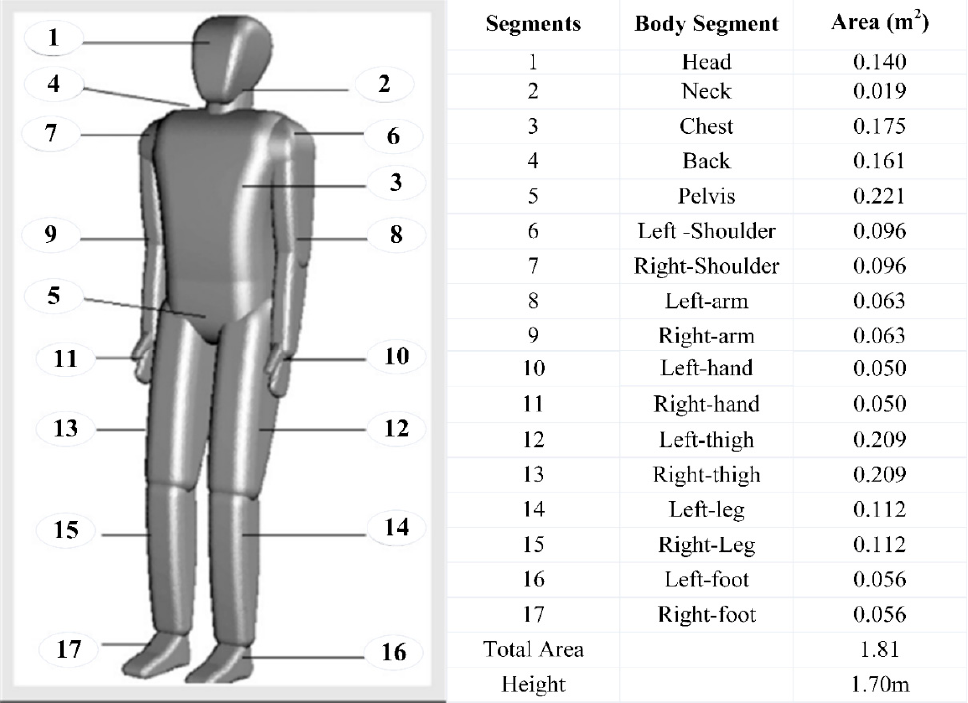
Figure 1. Thermal